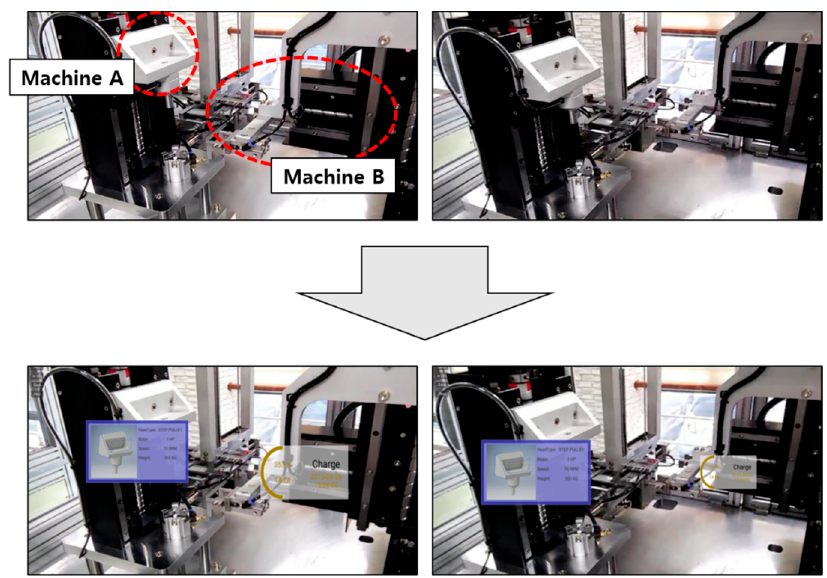
Figure 16. Application of the proposed industrial AR to an assembly line in a smart factory.